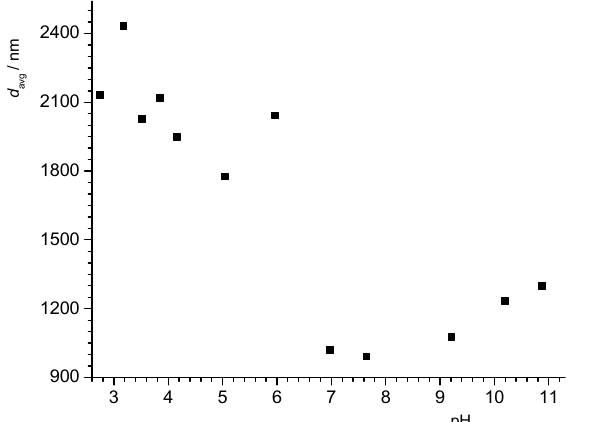
Figure A4. Average hydrodynamic diameter of graphite particles. γ = 0.040 g dm − 3 , I c = 2 mmol dm − 3 , θ = 25 °C.